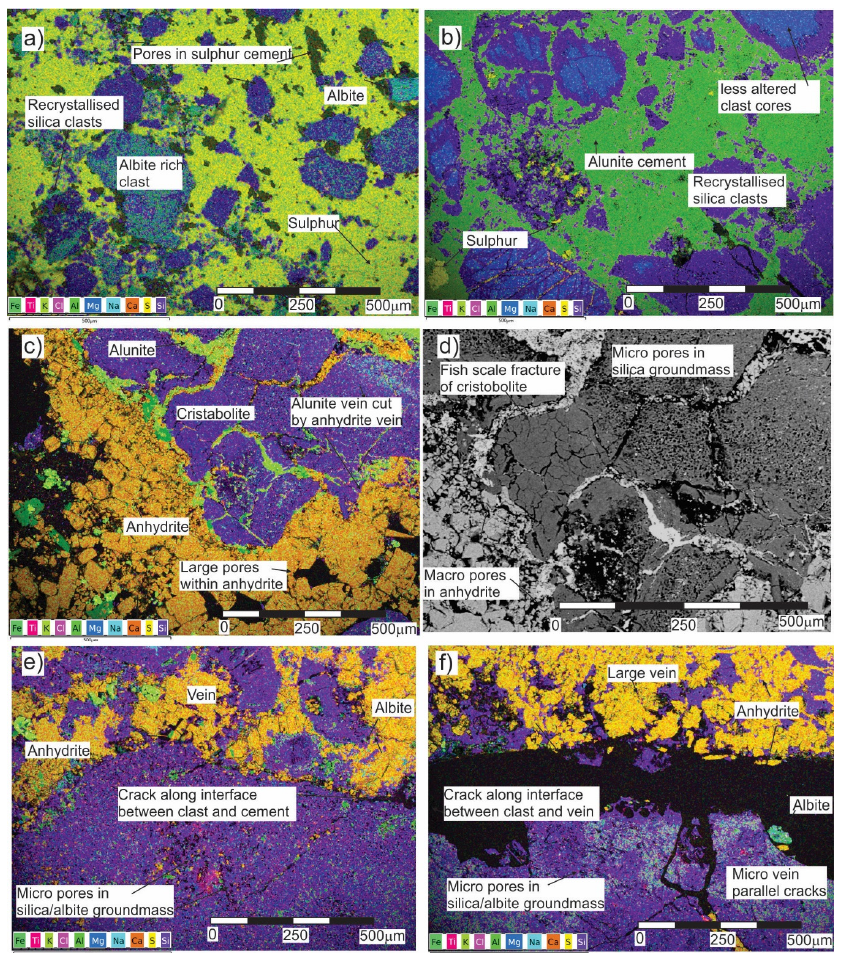
Figure 5. Scanning Electron Microscopy EDS (Energy Dispersive X-ray Spectroscopy) element maps of ( a ) EDS stacked image of sulfur cemented ash tuff; ( b ); EDS stacked image of alunite cemented portion of hydrothermal breccia ( c ) EDS element map of hydrothermal breccia; ( d ) same sample as c) in backscatter to highlight porosity distribution e) EDS stacked image of hydrothermal breccia f) EDS stacked image of open vein in hydrothermal breccia.